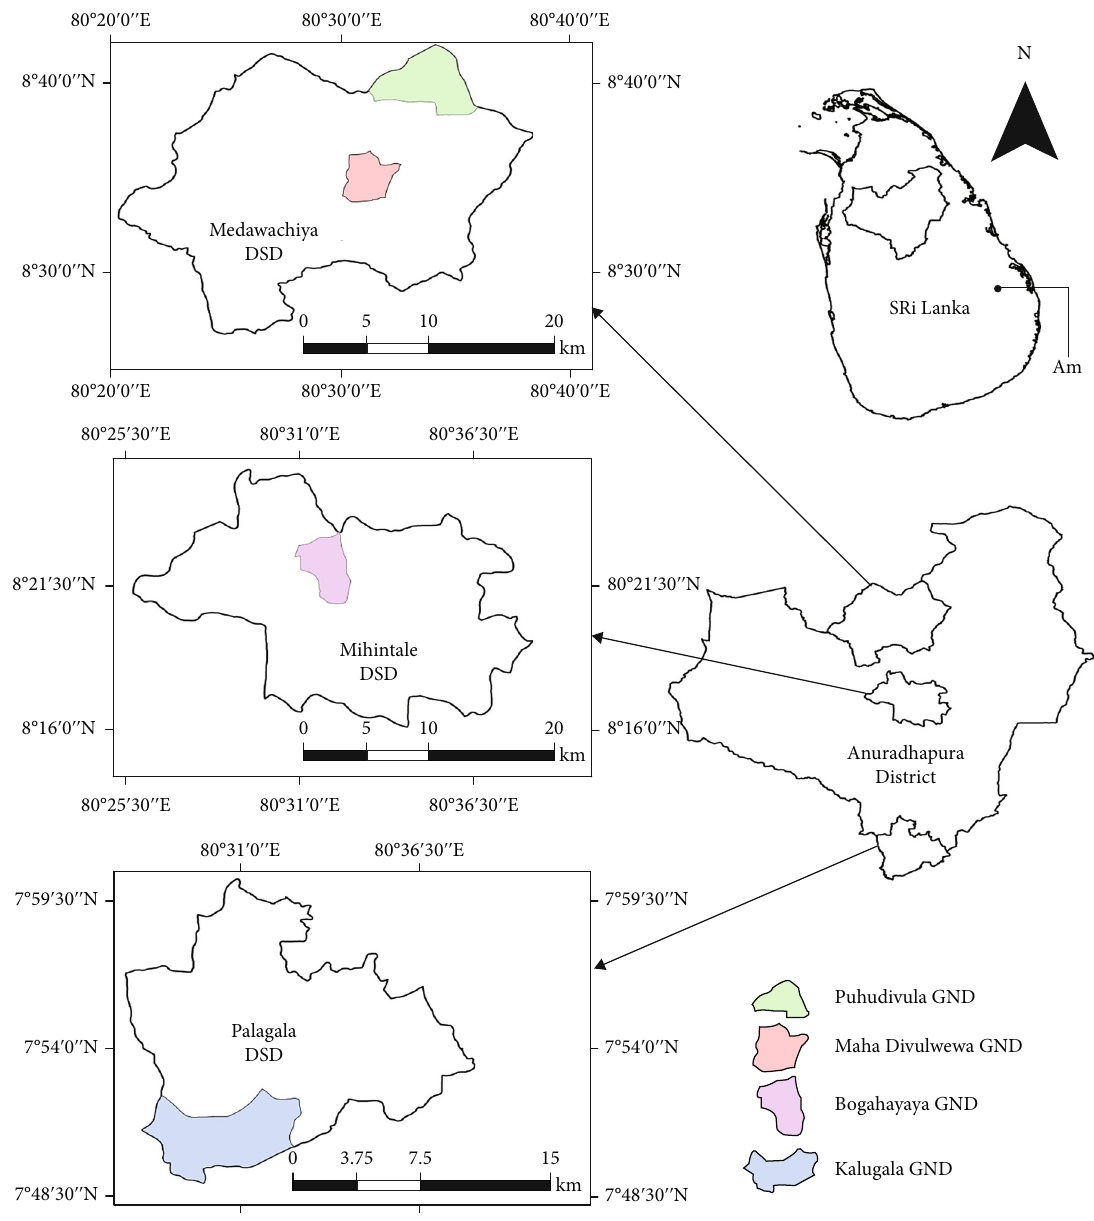
Figure 1: Study areas Am-Buddahangala GND in